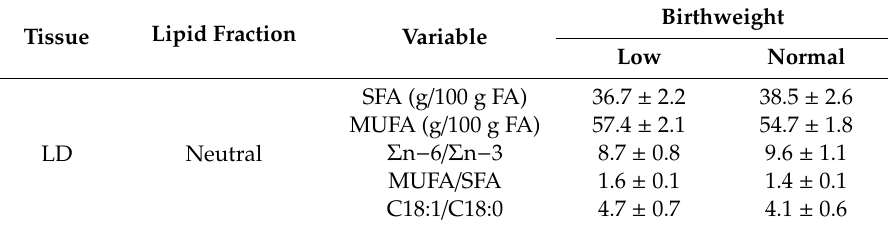
Table 7. Highlighted significant di ff erences ( p < 0.05) in muscle fatty acid composition between pigs with normal and low birthweight at 180 days